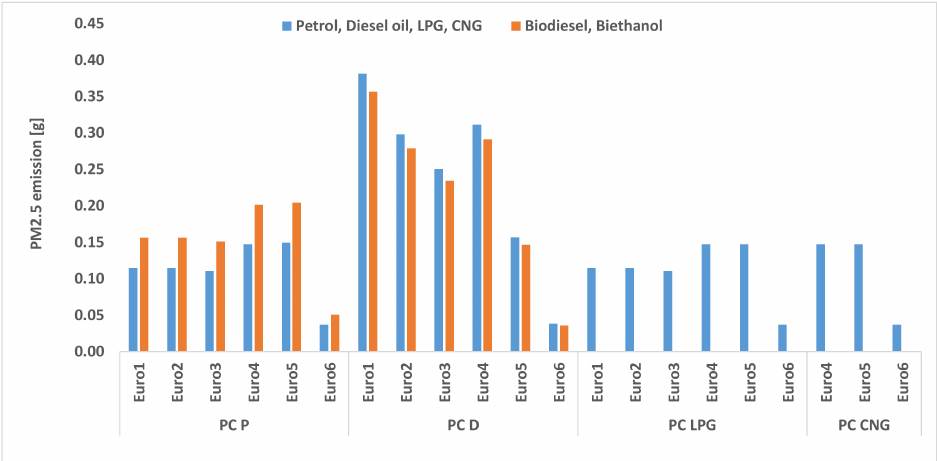
Figure 12. Comparison of PM2.5 emissions from PCs depending on Euro standard and fuel type.